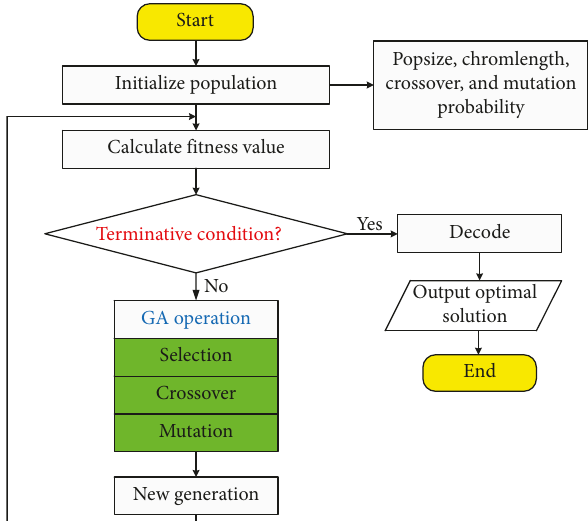
Figure 2: The flowchart of genetic